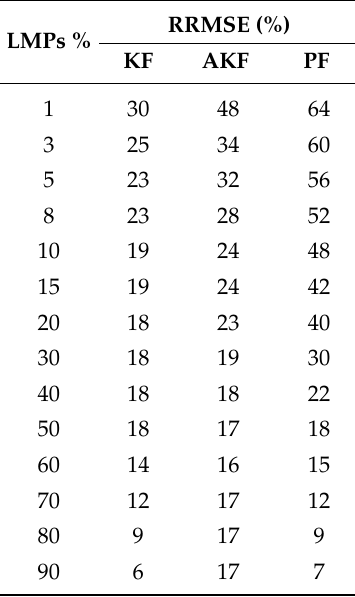
Table 2. Relative root mean square error (RRMSE) of KF, AKF, and PF approaches for different levels of market penetration rate